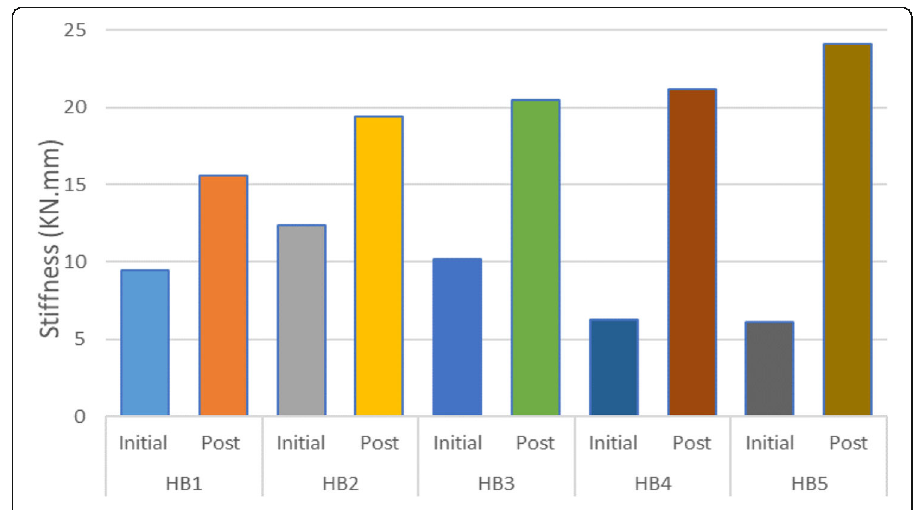
Fig. 15 Initial/post cracking stiffness of tested